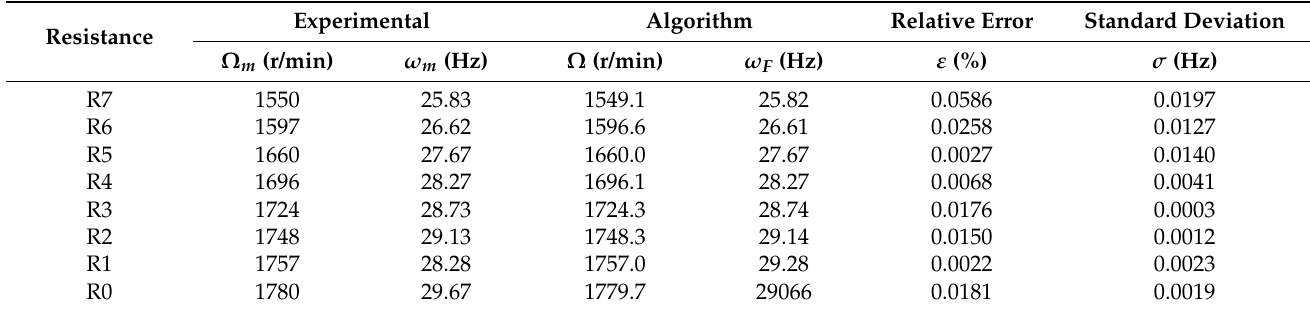
Table 12. DC generator coupled to the motor shaft: estimated speeds and frequencies, the relative errors, and the standard deviations for load tests at 30 Hz.